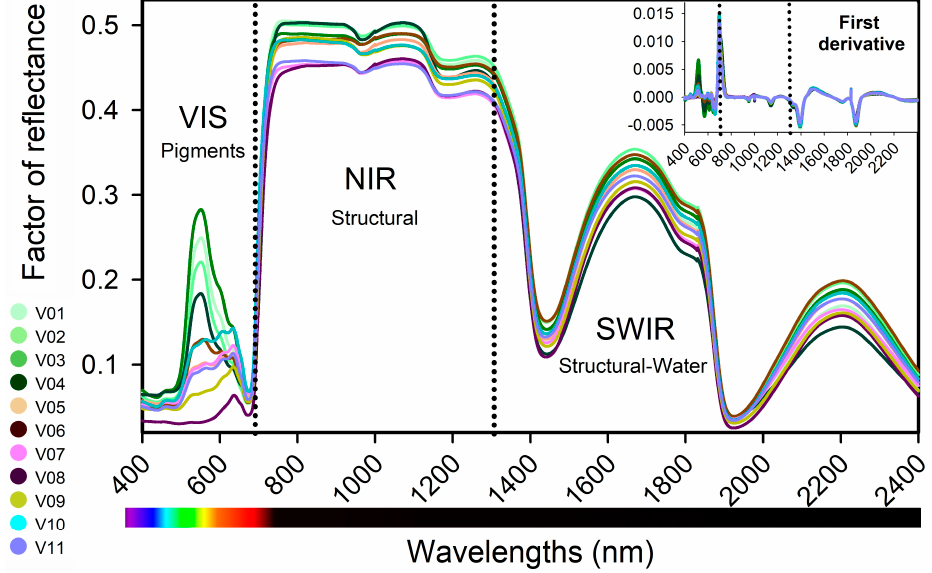
Figure 3. Average foliar VIS-NIR-SWIR reflectance hyperspectral factor of reflectance profiles (400– 2400 nm) of V01–V11, lettuce varieties. The inset displays the first derivative of the hyperspectral data. Note delimitation of the inflexion points of 700 and 1300 nm. ( n = 66). Standard error was omitted for clarity.